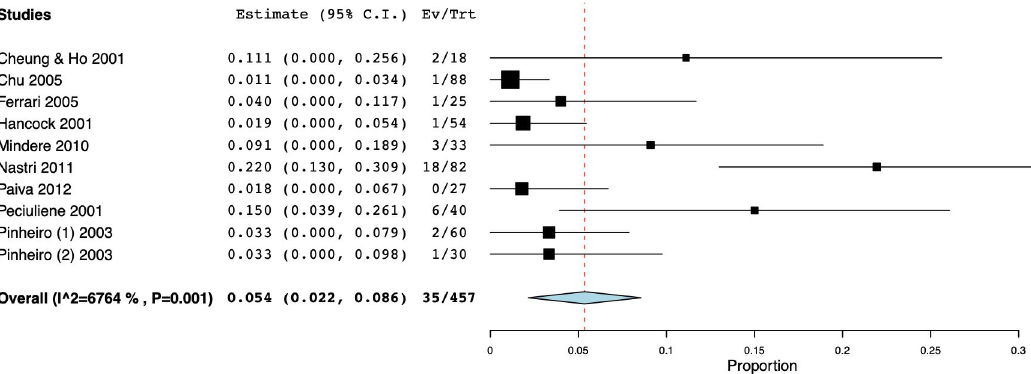
Fig 6. Forest plot representing fungal species prevalence in cultural studies evaluating teeth with primary and secondary endodontic infections with periapical lesions.